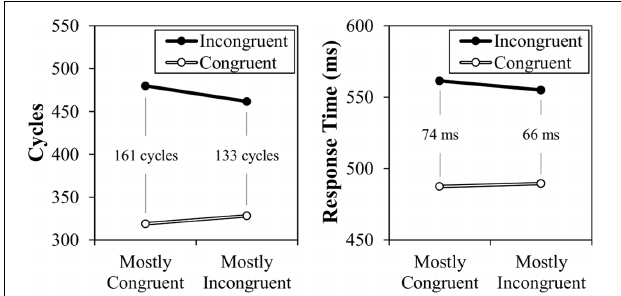
FIGURE 6 | Simulation 2 model cycle times (left) and participant data (right) for diagnostic